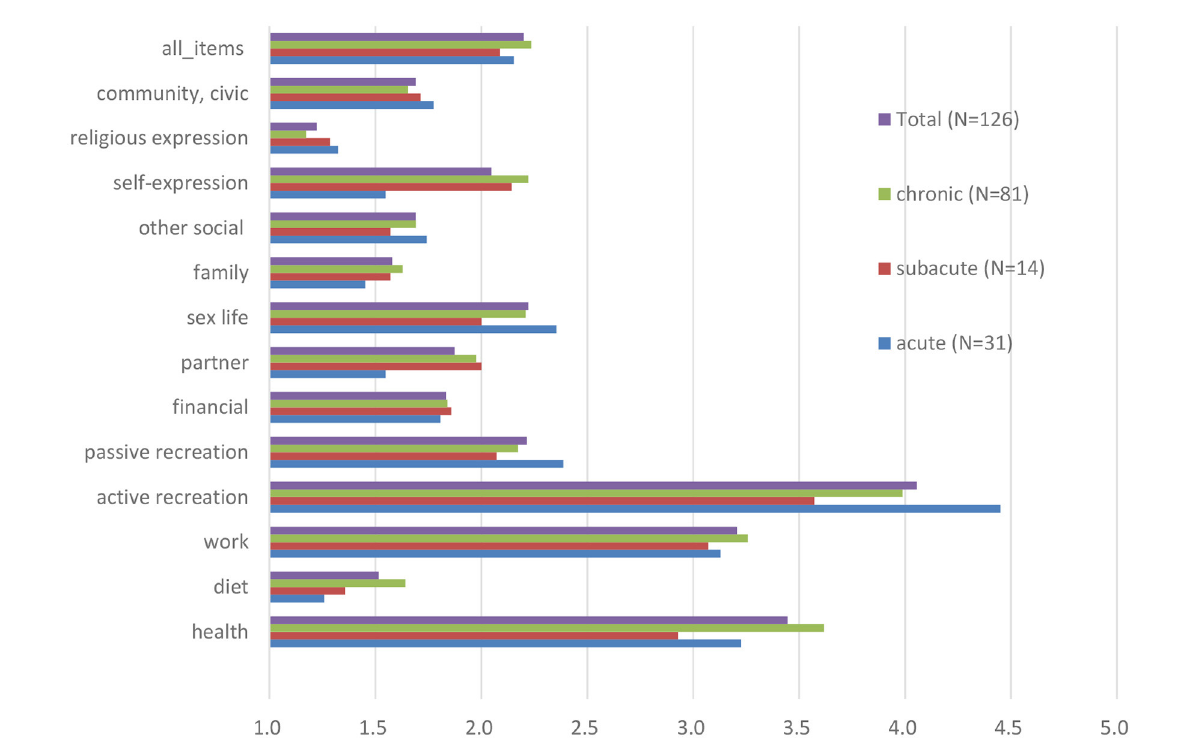
FIGURE1 Illness Intrusiveness Ratings Scale scores (mean of all items and individually for each item) among patients with low back pain, stratified by pain duration at